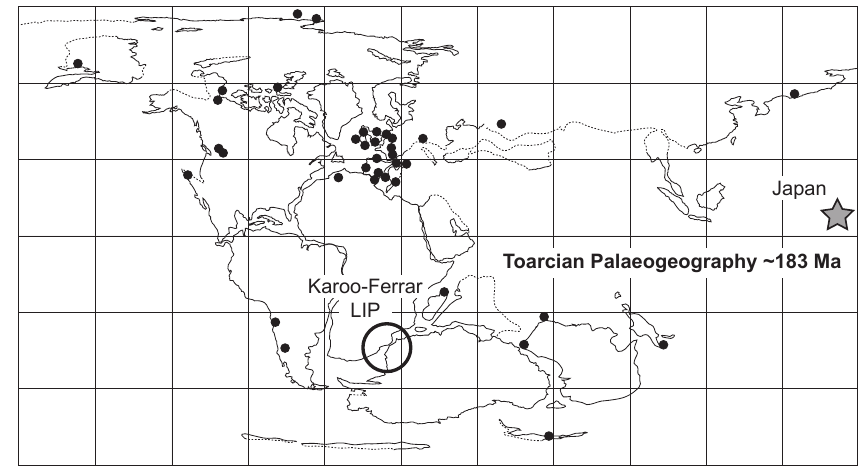
Fig. 1. Palaeogeographic map of the Early Jurassic showing the distribution of organic matter-rich facies (filled circles) dated as early Toarcian (modified from Jenkyns et al., 2002). The star indicates the approximate palaeogeographic location of Japan during the deposition of the Toarcian succession. The large circle represents the location of the Karoo-Ferrar large igneous province.